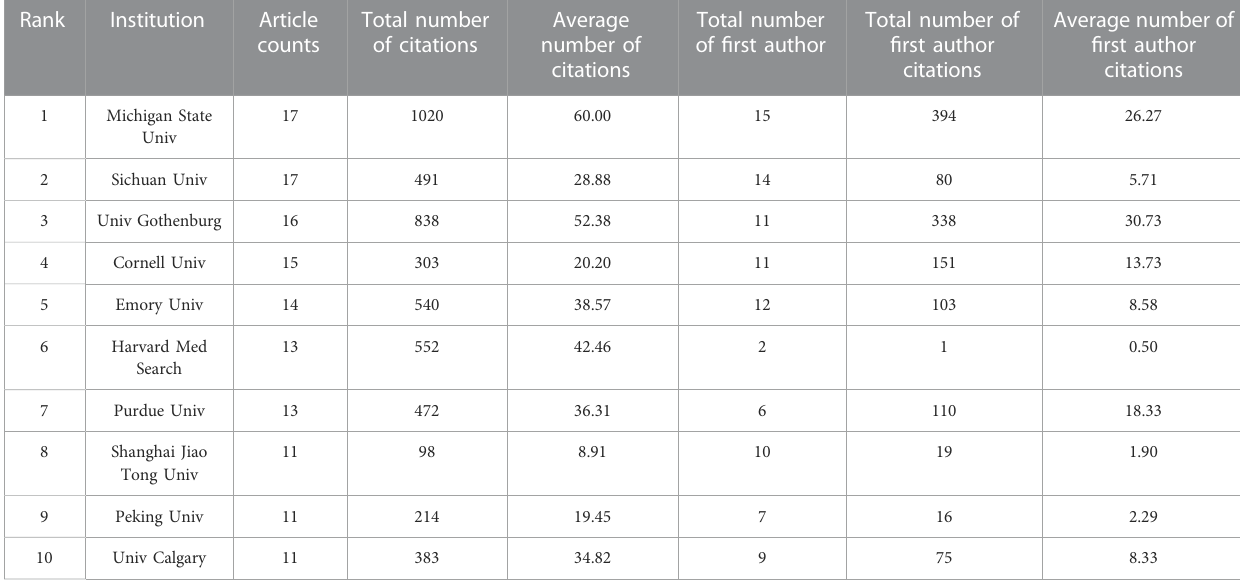
TABLE 1B The top 10 institutions with the highest number of published